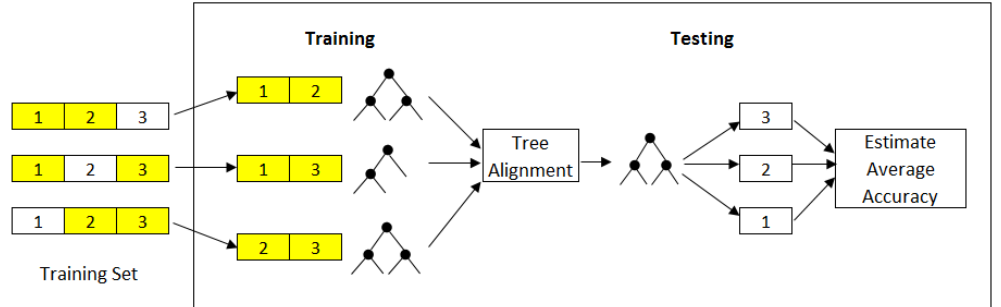
Figure 2. Illustration of our proposed method for sensor selection. Tree building is first performed on each training set. Then, tree alignment is performed to find a tree such that the similarity between this tree and all other trees is